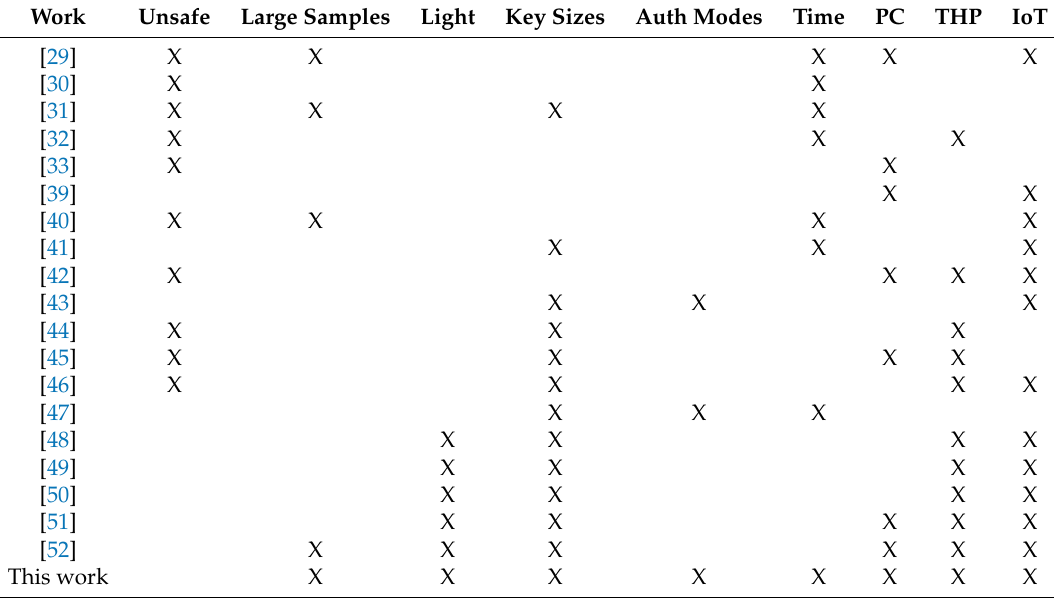
Table 1. Comparison of related work with the study made in this